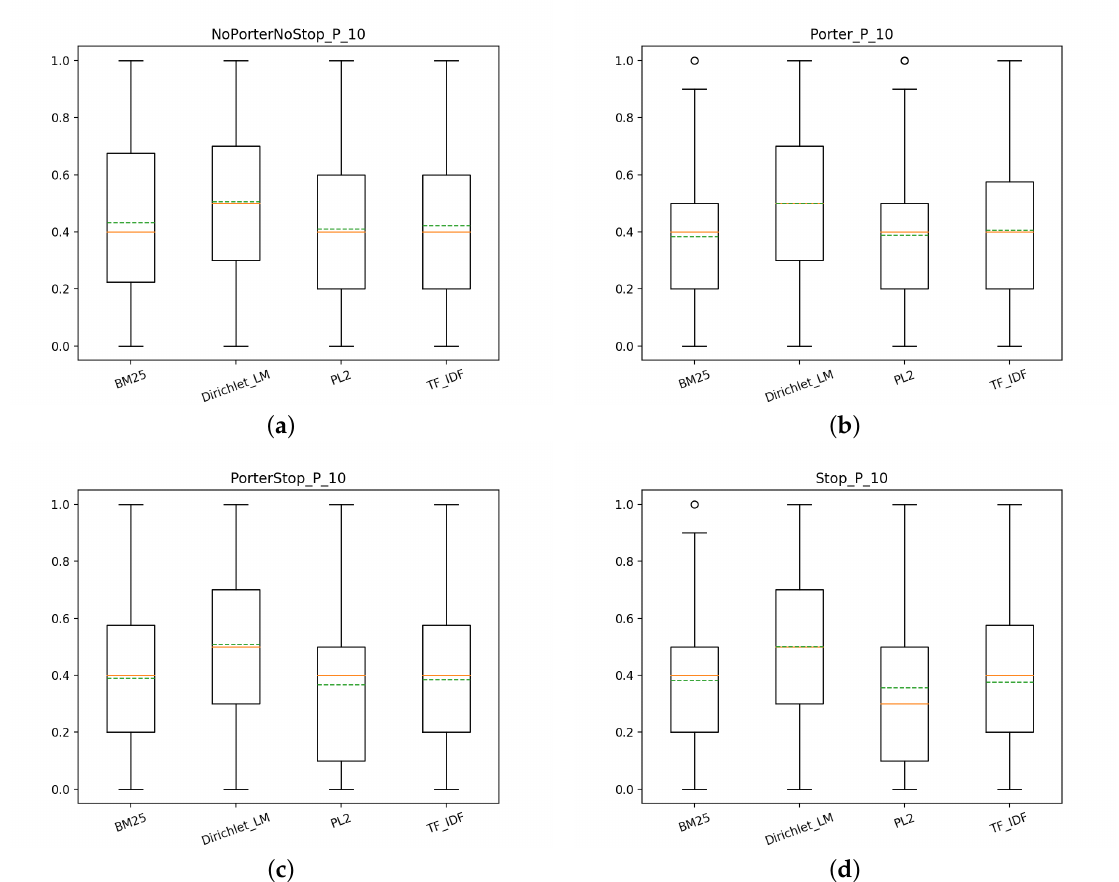
Figure 10. T2: box plots for P@10 of the different models for each index, with QE and RF: ( a ) NoPorterNoStop indexs, ( b ) Porter index, ( c ) PorterStop index, ( d ) Stop